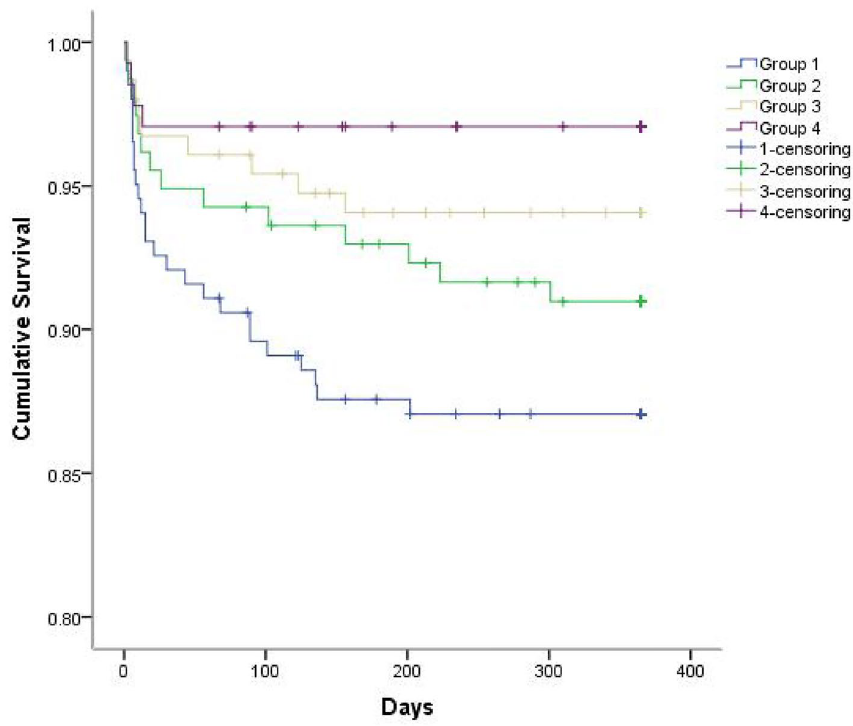
Figure 1. Kaplan–Meier survival curve of cumulative survival at 1-year follow-up for whole study population (log-rank test, P = 0.008). (group 1, hypertension with Hcy ≥ 15 µmol/L; group 2, hypertension with Hcy < 15 µmol/L; group 3, no-hypertension with Hcy ≥ 15 µmol/L; group 4, no-hypertension with Hcy < 15